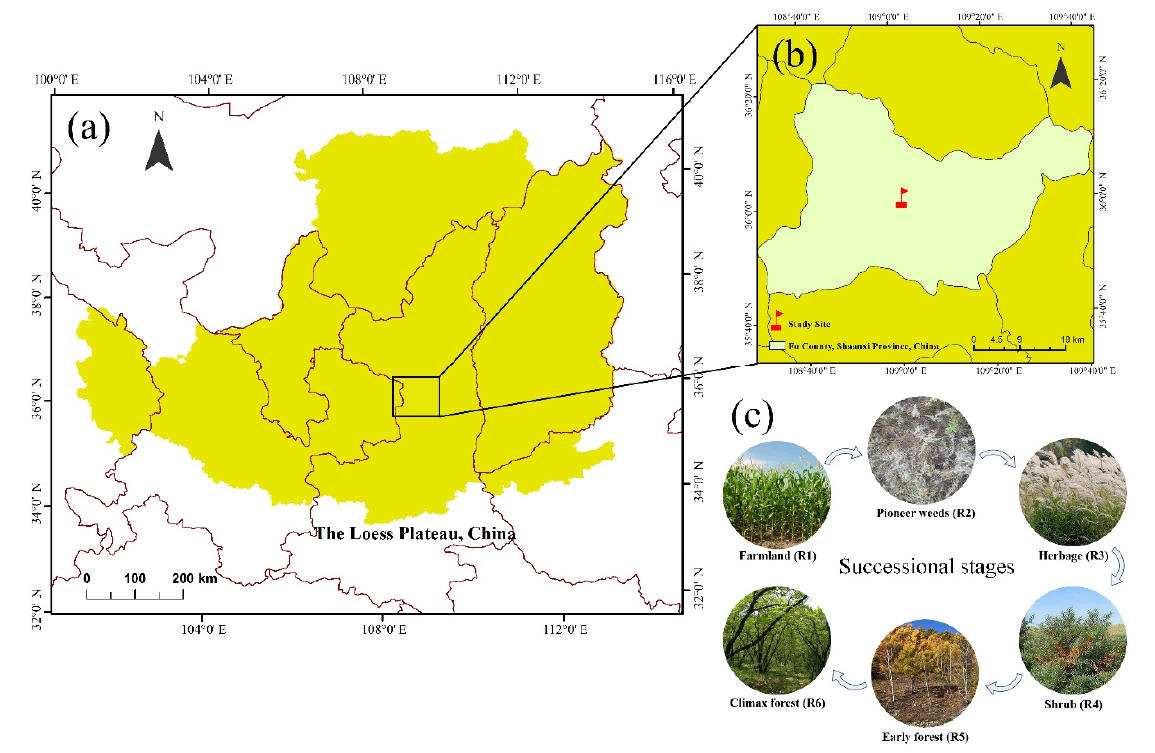
Figure 1. ( a ) The geographical location of the Loess Plateau, China, ( b ) the study site in Fu County, Shaanxi Province, China, ( c ) and the photographs of the study site at each successional stage.